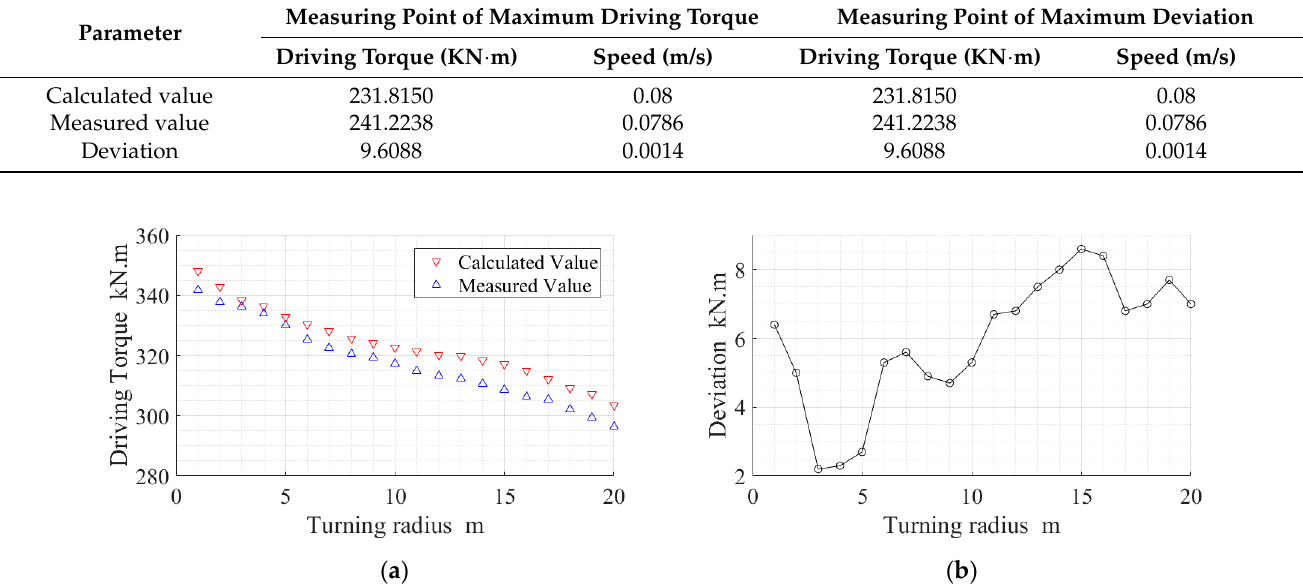
Figure 8. Experimental data of turning motion on slope, (a) Driving Torque of Calculation and Measuring, (b) Deviation Torque. Table 2. Comparison between experimental and calculated data of turning motion on